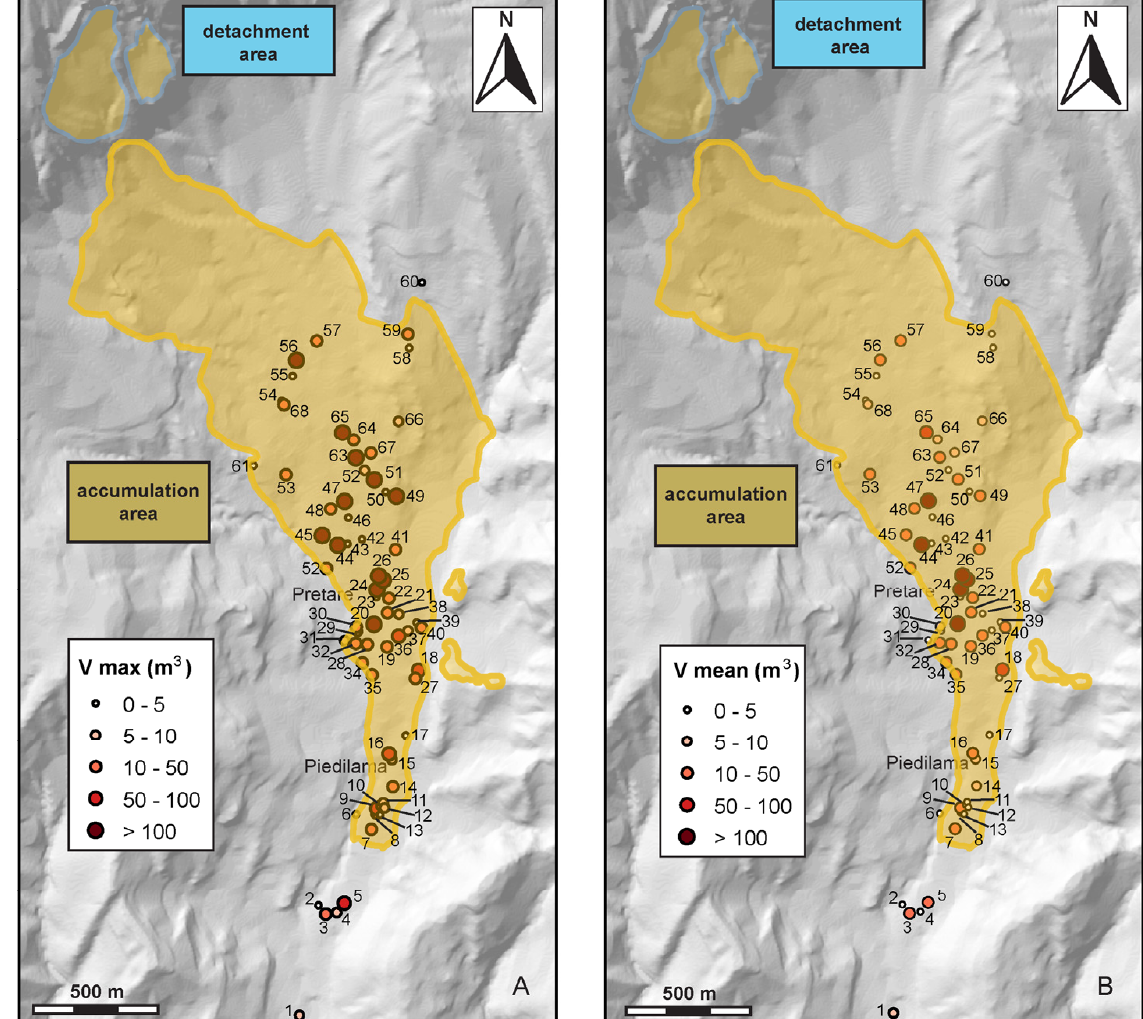
Figure 13. Spatial distribution of ( A ) maximum (V max ) and ( B ) mean (V mean ) block volume across the rock avalanche deposit. Each number refers to the corresponding station reported in Table 1. In the down valley, the deposit spreads on an E-W axis and reaches the maximum planimetric width (Wa, approximately 1.2 km); here, the topographic surfaces of the landslide body end up deeply incised and bordered by a bedrock salient on its eastern edge (Figure 14d, section B-B’). The clastic deposits in the central and distal sectors are narrow and elongated in a N-S direction (Figure 14a) following the valley orientation. In several parts (e.g., Figure 14e, section C-C’) a hummocky morphology can be noticed, which represents a typical feature of rock-avalanche deposits. As already observed in central Apennines for the Campo di Giove [24] and Lettopalena [25] rock avalanches, another typical feature of this kind of deposit is the presence of run-up zones, where the high-energy clastic flow can move counter-slope. In this case, two small clastic deposits were recognized overlying the arenaceous bedrock on the eastern slope of the Pretare-Piedilama Valley, (Figure 14f, section D-D’). The flowing mass could have had enough kinetic energy to climb up on the side of the valley. Nonetheless, it is important to note that the elevation difference between the valley floor and the run-up areas (approximately 50 m) is too high for assuming a simple run-up process. According to Tortorici et al. (2019) [58] the entire elevation difference was generated by the activity of a Quaternary west-dipping normal fault, the Pretare-Piedilama Fault, located at the base of the slope (Figures 5 and